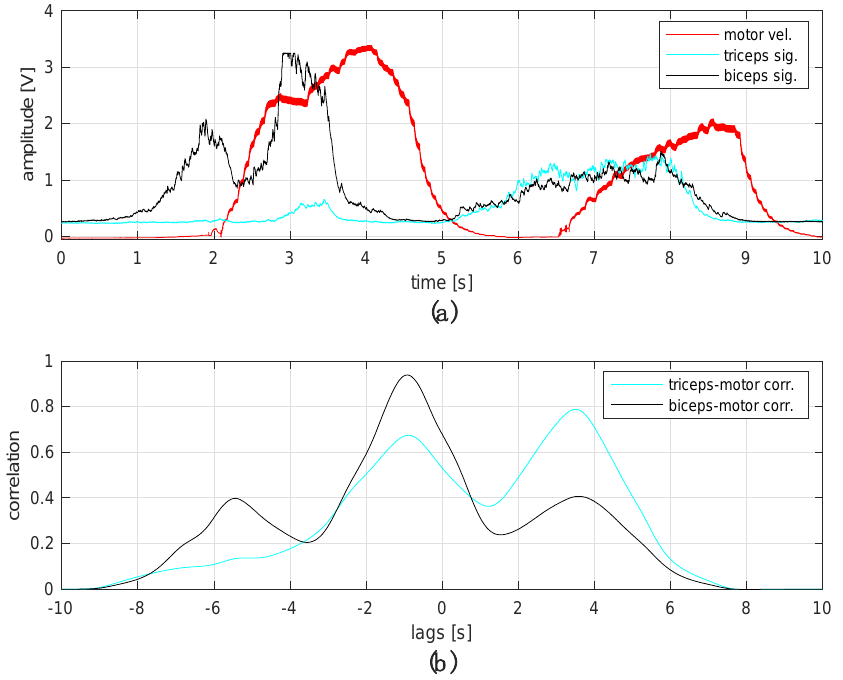
Figure 12. Reaction of the engine to a given EMG control signal (color: black - biceps signal; blue - triceps signal; red - analog interpretation of engine; speed, green - first direction of rotation, blue - second direction of rotation) ( a ), normalized correlation between the processed triceps and biceps signals and motor reactions ( b ).